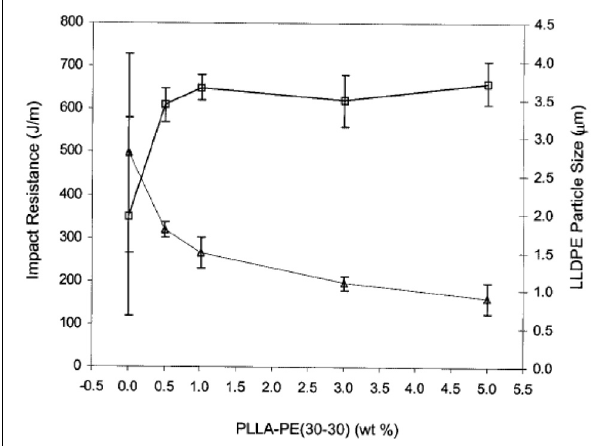
FIGURE 14 | Effect of the amount of PLLA–PE(30–30) block copolymer on the impact resistance (squares) and the LLDPE particle size